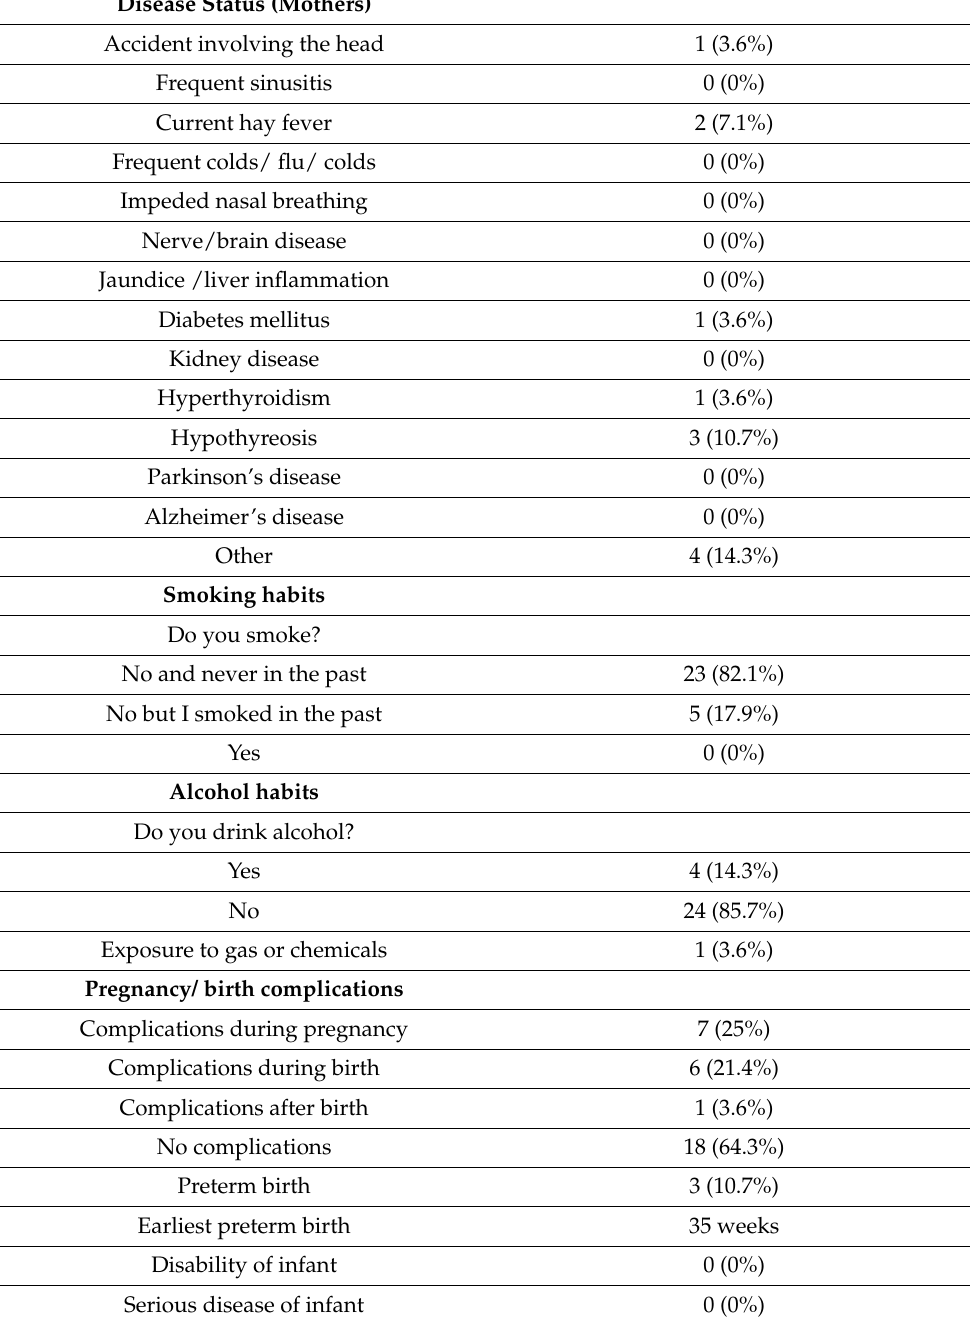
Table A3. Health status of